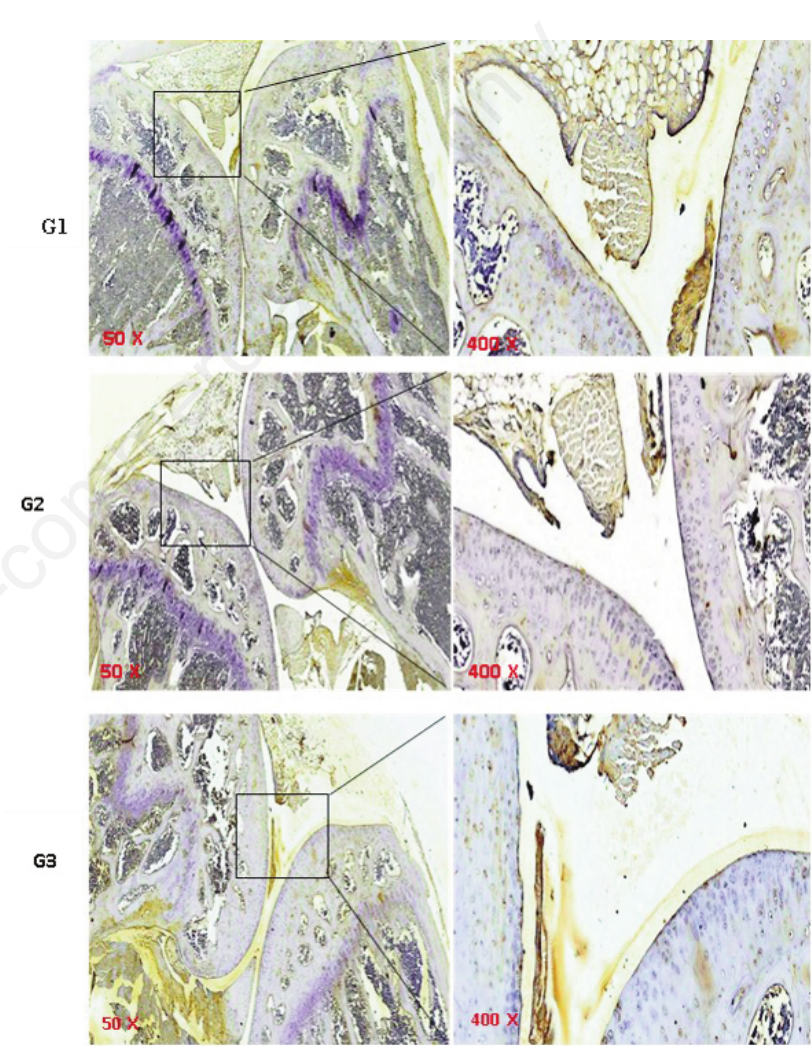
Figure 3. Images of the expression of HIF-1 a magnification light microscope a 50x in the left box were enlarged and are shown in the right box 400x. Brown living cells that express HIF-1 were living cells that did not express HIF-1 ACIA with HBO 2.4 ATA for 10 consecutive days; G3 = ACIA with HBO 2.4 ATA for 5 consecutive days, then rested 5 days, then for 5 consecutive days